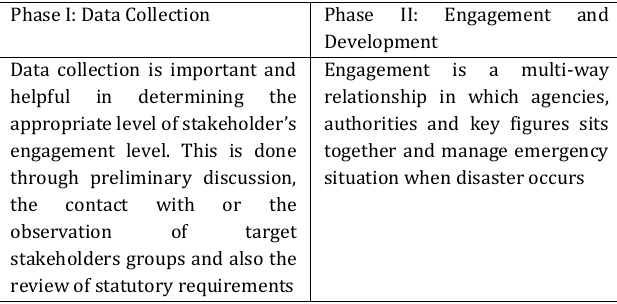
Table 2: Two different phases for